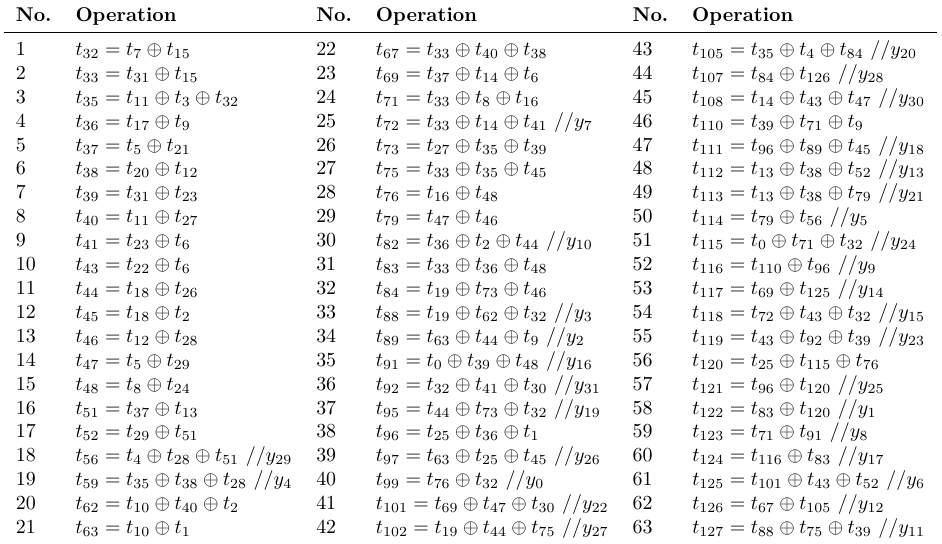
Table 5: An implementation of AES MixColumns with 255 GE for STM 130 nm library. It uses 29 XOR2 gates and 34 XOR3 gates. t 0 , t 1 , . . . , t 31 are the input values. The output values are y 0 , y 1 , . . . , y 31